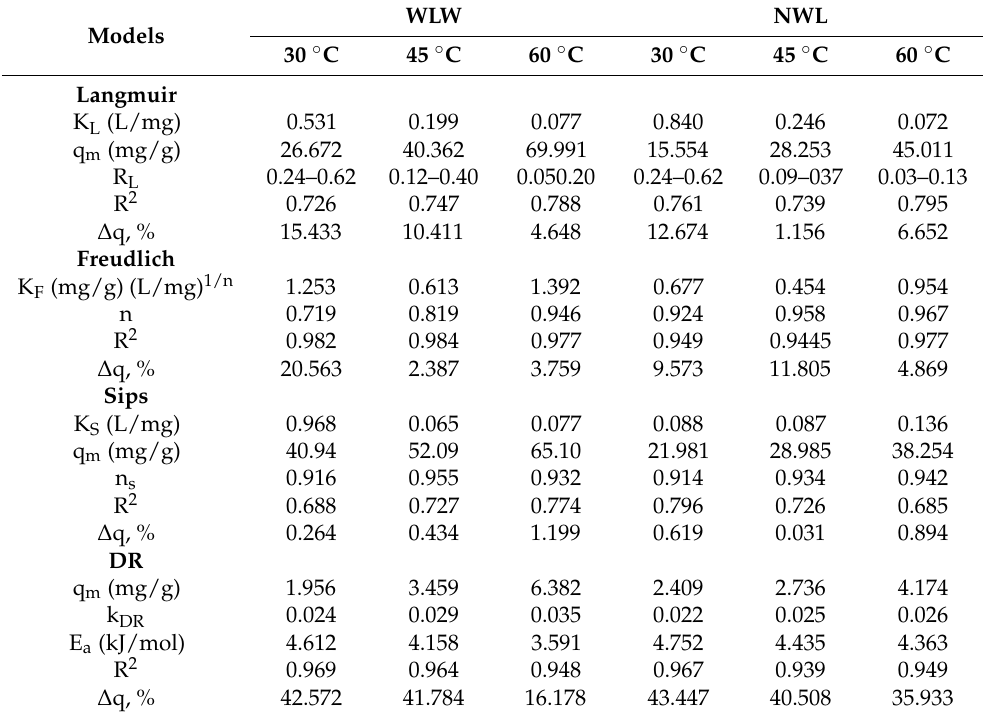
Table 3. Parameters for the isotherm models and GV adsorption with